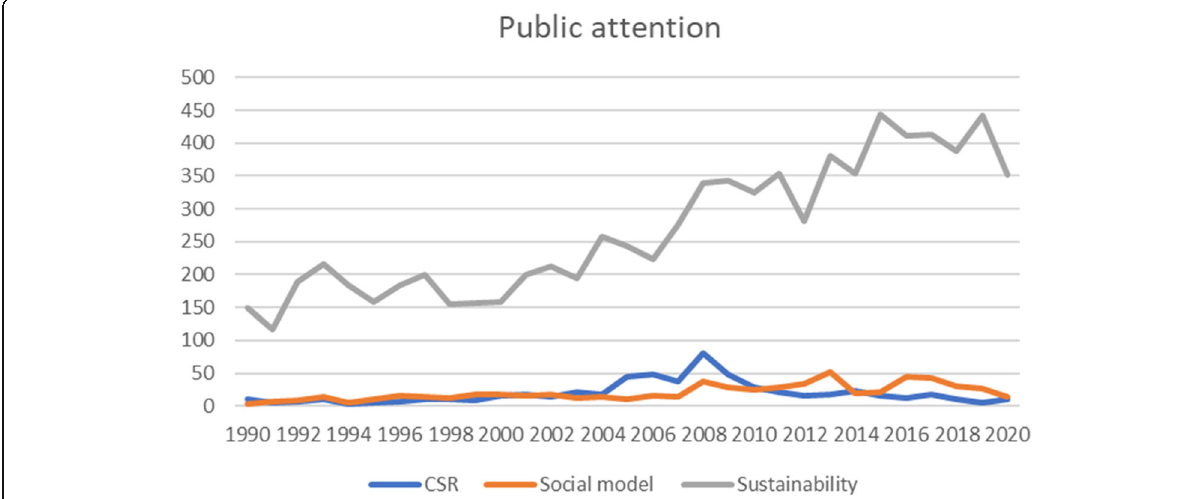
Fig. 1 Graphical representation of search results. Database: Atekst. Data is collected using searches samfunnsansvar AND bedrift* , “ den norske modellen ” , and bærekraft* specified to the period 1.1.1990 – 31.12.2020 in the newspaper